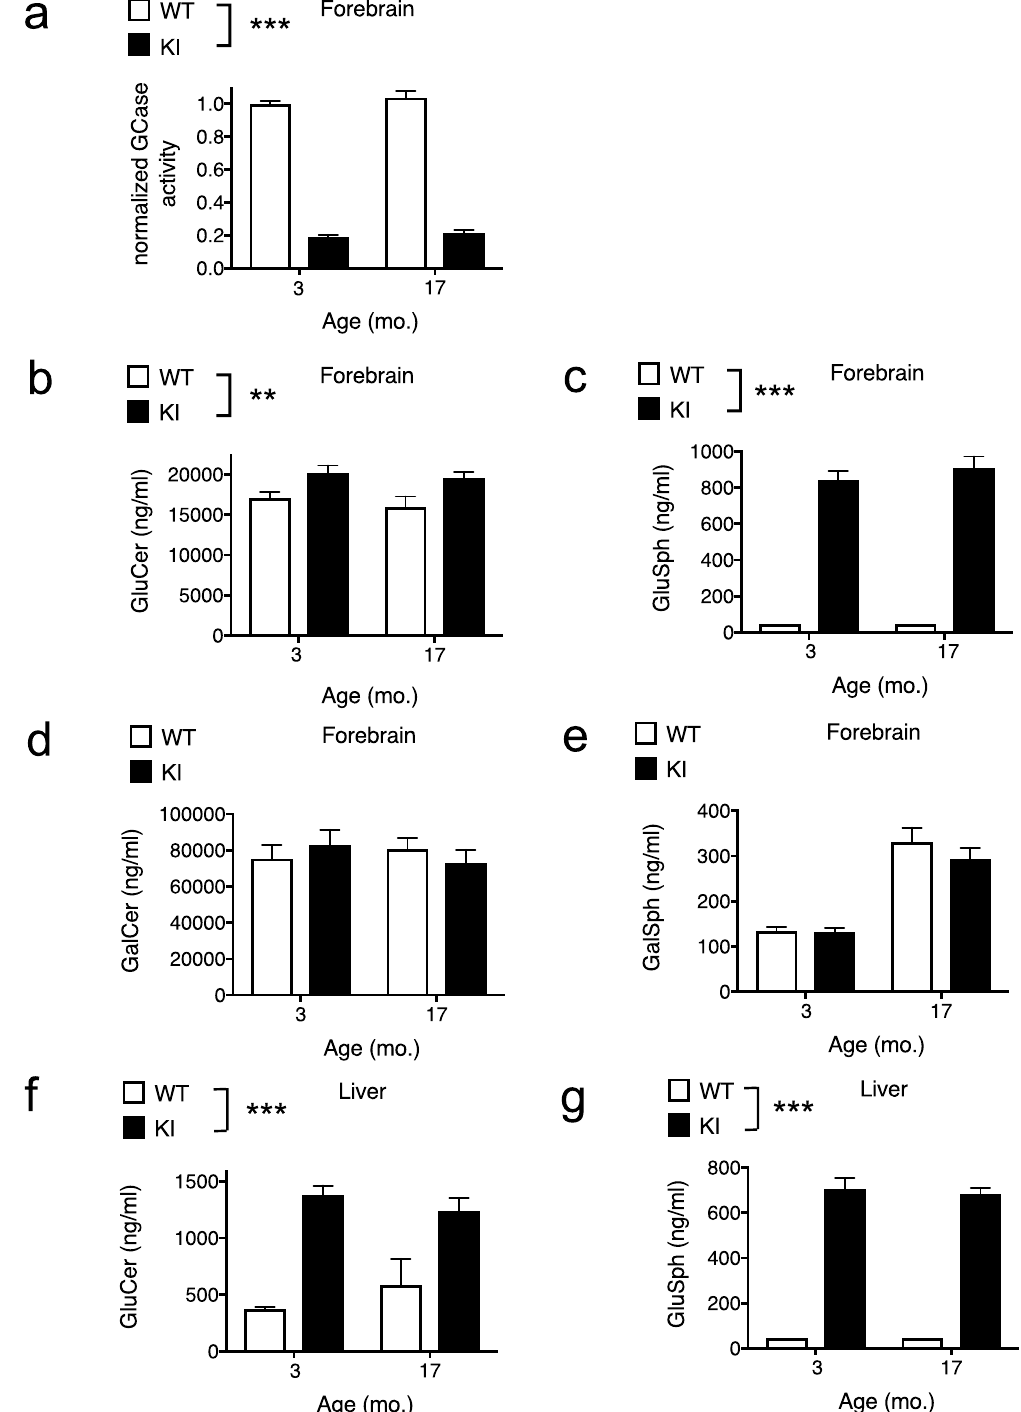
Figure 1. Decreased GCase activity and increased GluSph and GluCer levels in Gba KI mice. ( a ) GCase activity in the 4MU-Glu assay. GluCer levels ( b ) and GluSph levels in forebrain ( c ). GalSph levels ( d ) and GalCer levels ( e ) in forebrain. GluCer levels ( f ) and GluSph levels in liver ( g ). GalSph and GalCer levels in the liver were below detection limits (not shown). GCase activity was normalized to average GCase activity from 3-months old WT mice. Asterisks denoting significance levels for main effects of genotype are indicated next to the genotype symbols above the graphs. ** p < 0.01, *** p < 0.001. Values are displayed as mean ±